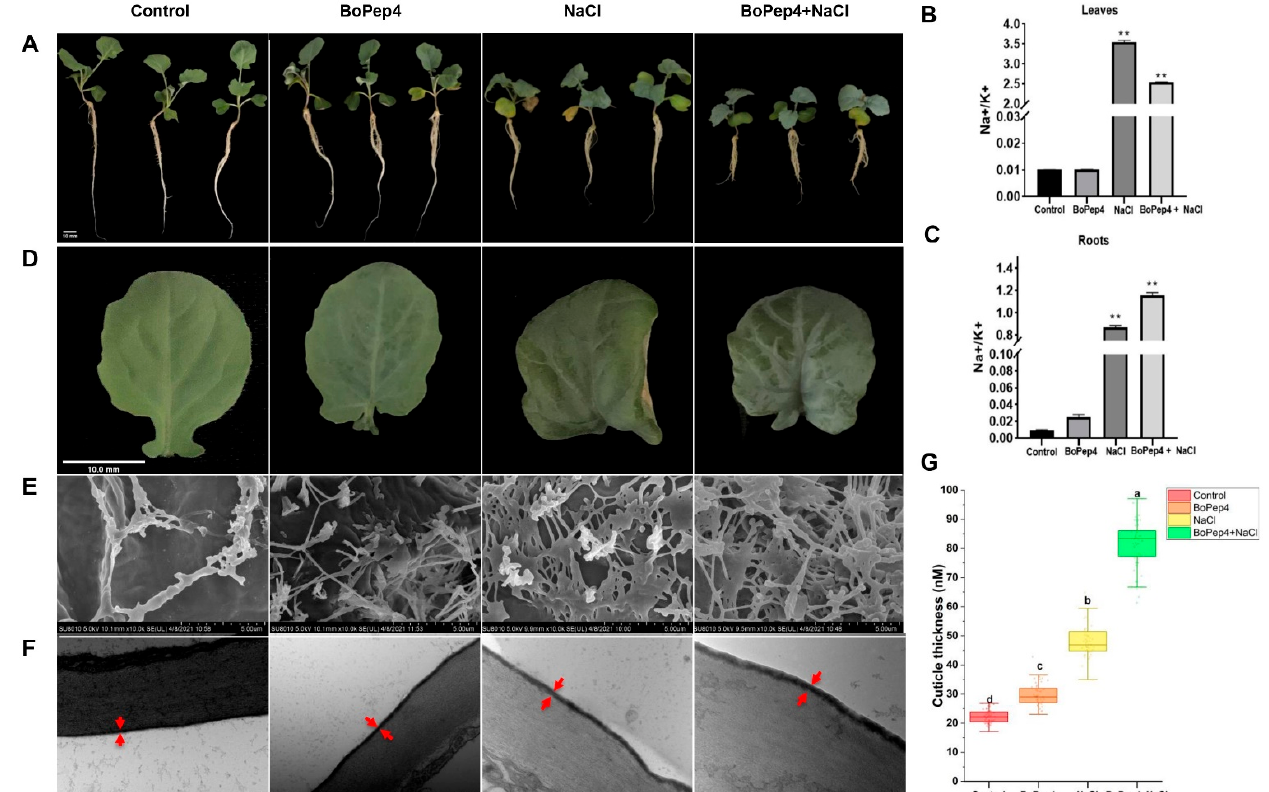
Figure 3. BoPep4 peptide application enhanced salinity stress tolerance in broccoli seedlings. ( A ) Phenotype of broccoli seedlings after 7 days of exposure to 100 nM BoPep4, 200 mM NaCl and pretreatment with 100 nM BoPep4 peptide for 3 days followed by combined treatment with 100 nM peptide plus 200 mM NaCl for 7 days; bar = 1 cm. ( B ) Na + /K + in leaves under different treatments. ( C ) Na + /K + in roots under different treatments. (* 0.01 < p < 0.05, ** p < 0.01) ( D ) Broccoli leaves under different treatments. ( E ) Scanning electron microscopy (SCM) images of cuticular wax crystals on the leaves of broccoli under 100 nM BoPep4, 200 mM NaCl and combination treatments. ( F ) Transmission electron microscope (TEM) images (red arrow) and ( G ) thickness measurements of the cutin in the leaves of broccoli under 100 nM BoPep4, 200 mM NaCl and combination treatments. Values are the averages of three replicates ± SD. Different letters represent significant differences according to Duncan’s multiple range tests ( p < 0.05).